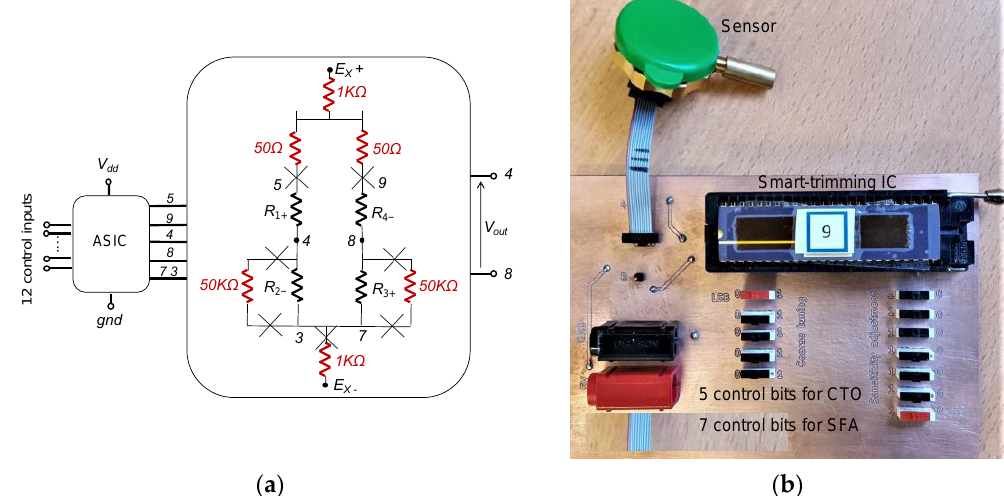
Figure 13. Proof of concept demonstrator with smart-trimming IC and a commercial piezo-resistive pressure sensor: ( a ) schematic, ( b ) printed-circuit board.